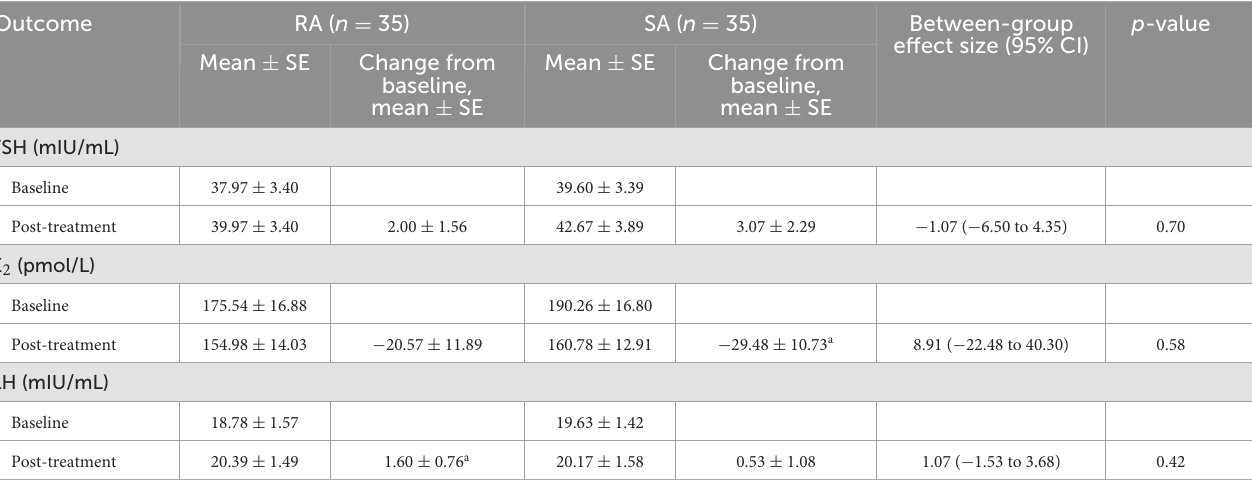
TABLE 8 Serum reproductive hormone levels across trial time-points (ITT dataset, participants = 70). Outcome RA ( n = 35) SA ( n = 35) Between-group Mean ± SE Change from